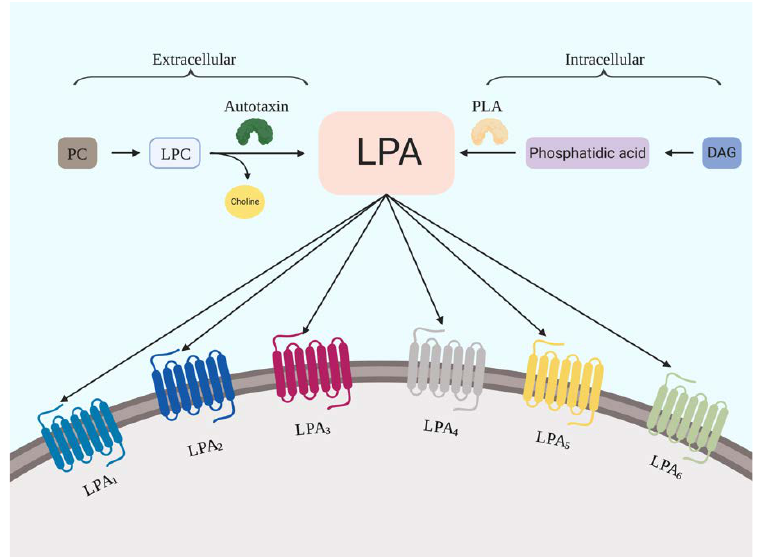
Figure 1. LPA metabolism. The generation of LPA is catalyzed by extracellular autotaxin or intracellular phospholipase A (PLA).